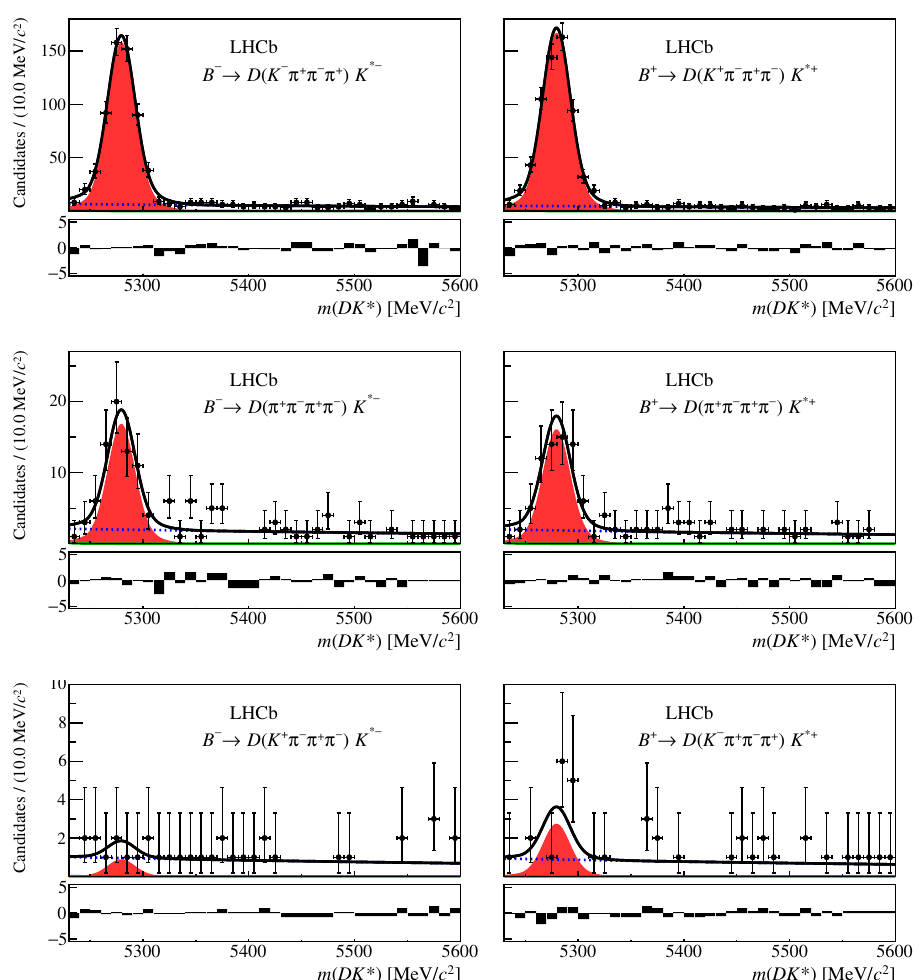
Figure 3. Result of (cid:12)ts to data for the four-body decay modes with Run 1, Run 2, long and downstream categories summed for presentation. The signal is represented by the red shaded area, the combinatorial background by the dotted blue line and the partially reconstructed background by the solid green line. The total (cid:12)t is given by the black line. The residuals are shown below each plot.